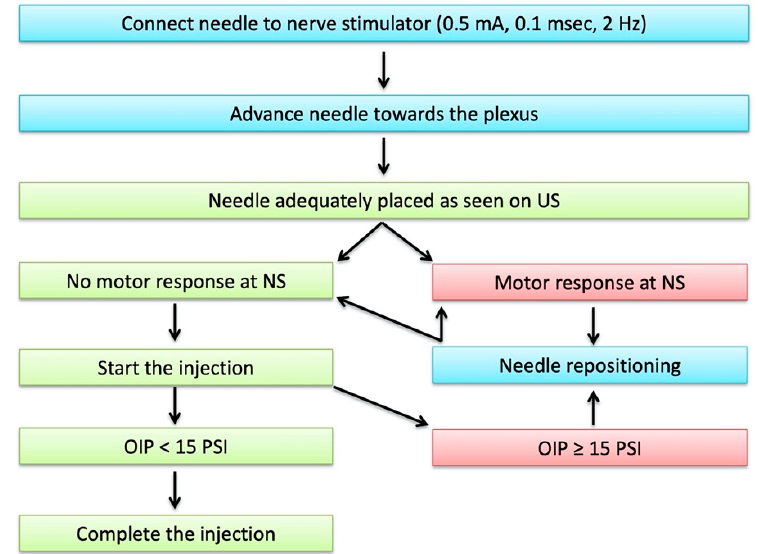
Figure 4. The triple monitoring flowchart. NS: nerve stimulation; US: ultrasound; OIP: opening Injection pressure.